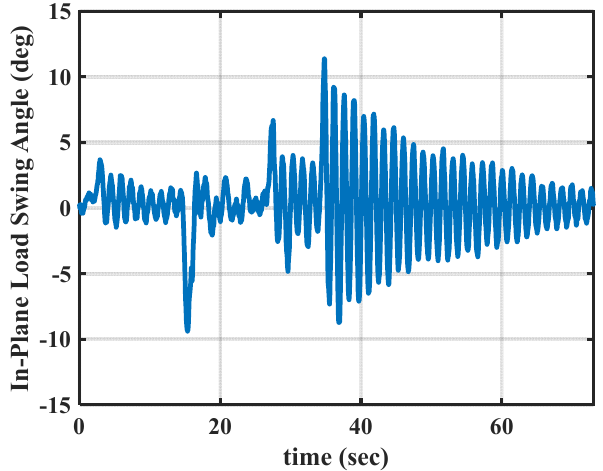
Figure 13. In–plane load swing angle ɸ L (as described in Figure 4).